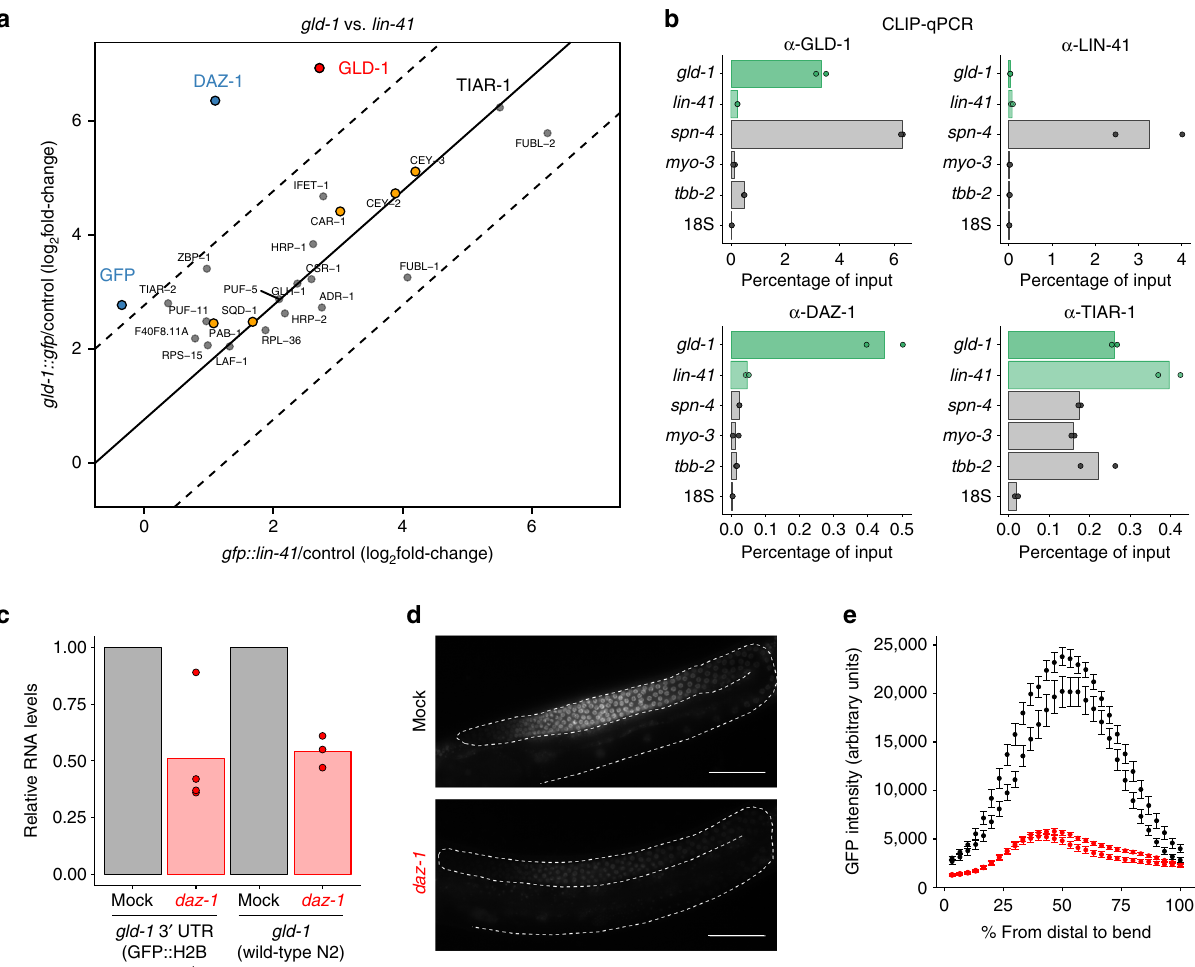
Fig. 4 vIPR reveals common and speci fi c RBPs, and identi fi es DAZ-1 as a gld-1 regulator. a Comparison of protein enrichment from vIPR of the gld-1::gfp and gfp::lin-41 transcripts. Proteins signi fi cantly more abundant for one transcript are colored blue (differential binding cut-off: >4-fold, adjusted p -value < 0.01, moderated t -test; BH-corrected; Supplementary Data 3). Red and yellow indicate known and likely binders of the gld-1::gfp transcript, respectively (see Fig. 2e). Solid line demarcates the transcript expression-adjusted diagonal (intercept = log 2 (250 TPM/147 TPM)), dashed lines demarcate the fold-change cut-offs. b Crosslinking and immunoprecipitation (CLIP) con fi rms that DAZ-1 speci fi cally interacts with gld-1 mRNA, while TIAR-1 binds all tested mRNAs. Experiments were performed with C. elegans strains expressing tagged versions of the indicated proteins. GLD-1 and LIN-41 CLIPs were performed as positive and negative controls for gld-1 binding, respectively. The spn-4 mRNA is a known germline target of LIN-41 77 and served to control for the integrity of tagged LIN-41 protein. Control CLIPs in wild-type worms did not enrich for any of the tested transcripts (<0.02% of input detected after CLIP). Experiments were performed with n = 2 biological replicates, bars represent means. Green: mRNAs assessed by vIPR. c Relative RNA levels of gld-1 3 ′ UTR reporter in transgenic worms, and endogenous gld-1 in N2 worms after mock and daz-1 RNAi treatment, measured by Nanostring nCounter and normalized to tbb-1/tbb-2 levels. Bars represent means, data are from n = 4 ( gld-1 reporter) and n = 3 (wild-type N2) independent biological replicates. See also raw data in Supplementary Data 5. d Representative microscope images of gld-1 3 ′ UTR reporter fl uorescence in gonads of transgenic worms upon RNAi treatment. Dashed lines encircle gonads. Scale bar: 50 µ m. e Quanti fi cation of GFP fl uorescence along the distal gonad. Plotted are mean GFP intensities for two independent transgenic lines of the gld-1 3 ′ UTR reporter upon mock and daz-1 RNAi treatment. Number of analyzed gonads – mock: n = 24, n = 18; daz-1 : n = 35, n = 23. Error bars represent SE. Source data are provided as a Source Data fi